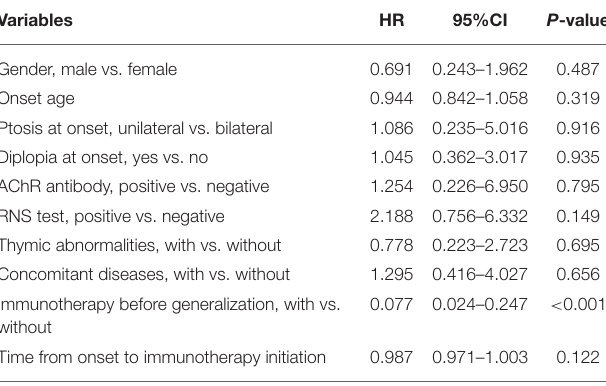
TABLE 3 | Cox regression analysis of risk factors for secondary generalization in patients with v-LOMG with pure ocular onset. Variables HR 95%CI P -value Gender, male vs.